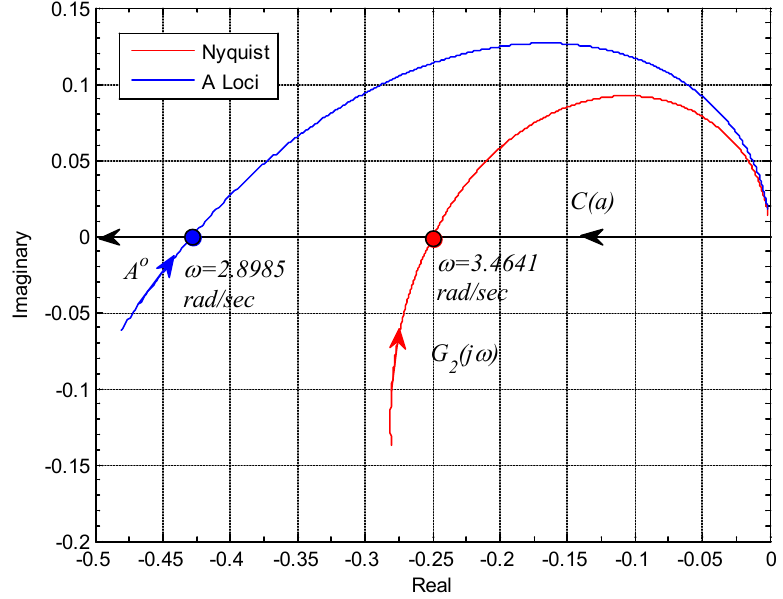
Figure 12. A Loci and Nyquist diagram of